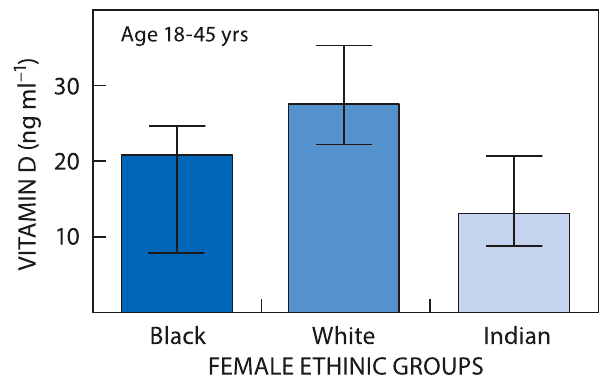
Figure 3: 25(OH)D among 18 – 45-year-olds.